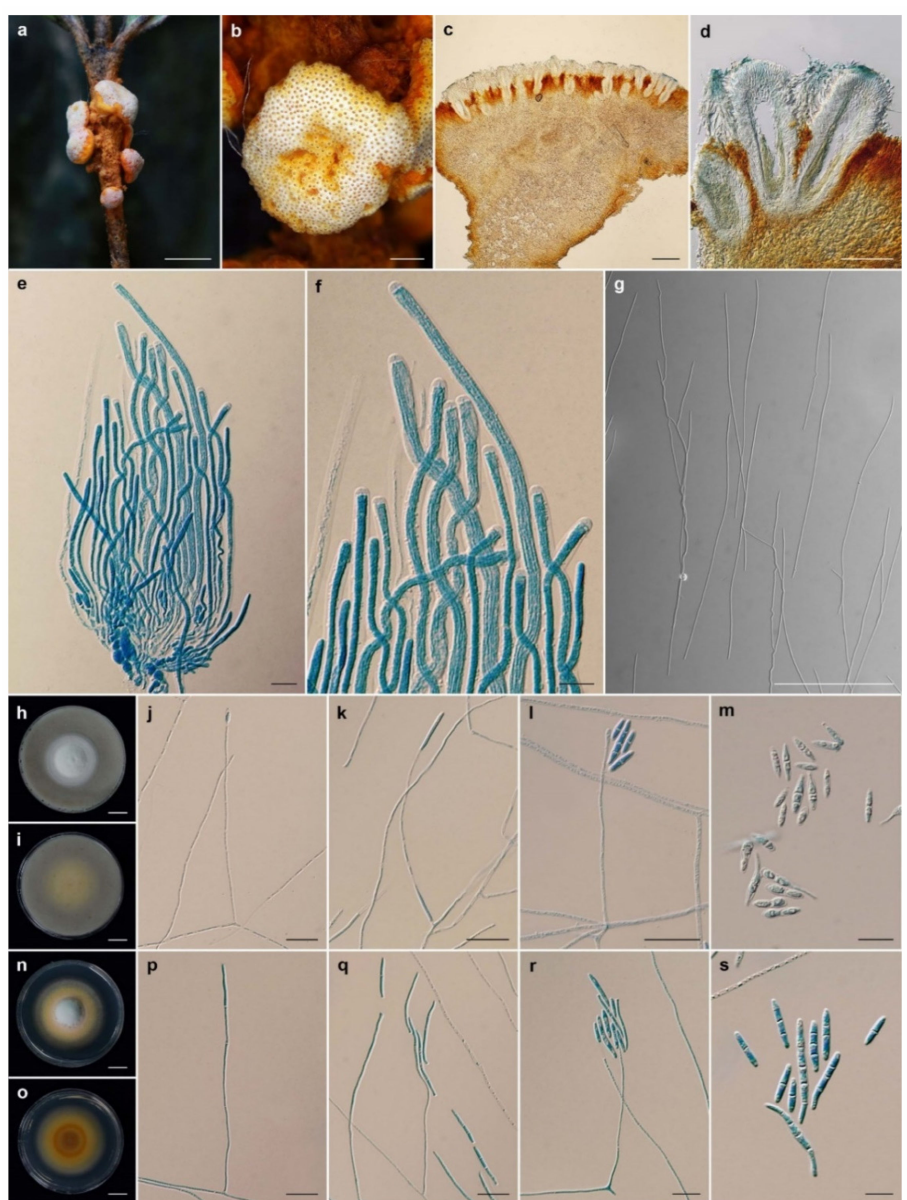
Figure 3. Ascopolyporus galloides . ( a , b ) Stromata on living stem of dicotyledonous plant (BBH48704); ( c ) cross-section through stroma showing perithecia; ( d ) perithecia; ( e ) asci; ( f ) asci-caps; ( g ) as- cospores; ( h ) colony obverse on OA; ( i ) colony reverse on OA; ( j – l ) phialide apex with conidial head on OA; ( m ) conidia on OA; ( n ) colony obverse on PDA; ( o ) colony reverse on PDA; ( p – r ) phialide apex with conidial head on PDA; ( s ) conidia on PDA. Scale bars: ( h , i , n , o ) = 10 mm; ( a ) = 5 mm; ( b ) = 1 mm; ( c ) = 200 µ m; ( d , g ) = 100 µ m; ( j , k , l , q , r ) = 20 µ m; ( e , f , m , p , s ) = 10 µ